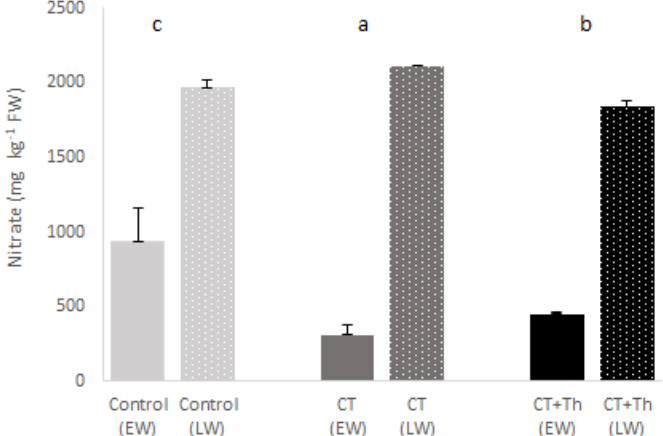
Figure 3. Effect of different compost tea (CT) treatments on nitrate content of baby spinach in both experiments. Bars are mean values n = 3. Error bars indicate standard deviation. Control: sprayed distilled water (12 m 3 per ha); CT: sprayed compost tea (12 m 3 per ha); CT + Th: sprayed compost tea (12 m 3 per ha) and T. harzianum T-78 (5 × 10 8 cfu mL − 1 per ha). EW: early winter and bars without points; LW: late winter and bars with points. Different lowercase letters about bars indicate differences between treatments ( p ≤ 0.05) in EW and different uppercase letters about bars indicate differences between treatments ( p ≤ 0.05) in LW.